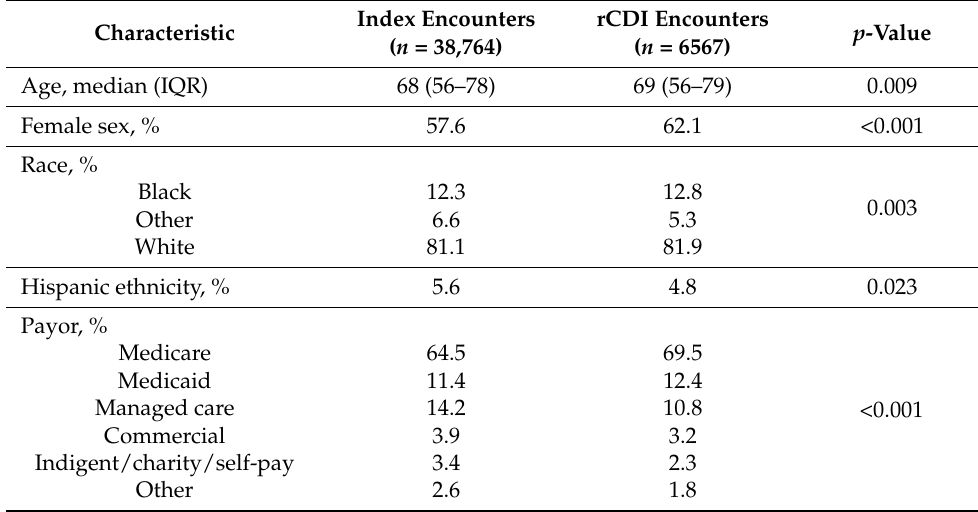
Table 1. Baseline characteristics of CDI